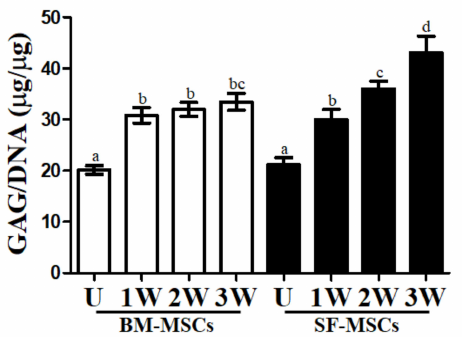
Figure 6. The values of glycosaminoglycan (GAG) content of BM- and SF-MSCs was evaluated one, two, and three weeks after induction. The GAG contents were significantly higher in groups following differentiation in SF compared to BM-MSCs after three weeks of differentiation. Values displayed are mean ± SD independent experiments ( n = 4). Different superscripts (a, b, c, and d) denote significant differences ( p < 0.05) among undifferentiated cells, and 1, 2, and 3 weeks of differentiated cells using BM-MSCs and SF-MSCs (white bar: undifferentiated cells; black bar: differentiated cells U: undifferentiated cells; 1W: one week after chondrocyte induction; 2W: two weeks after chondrocyte induction; 3W: three weeks after chondrocyte